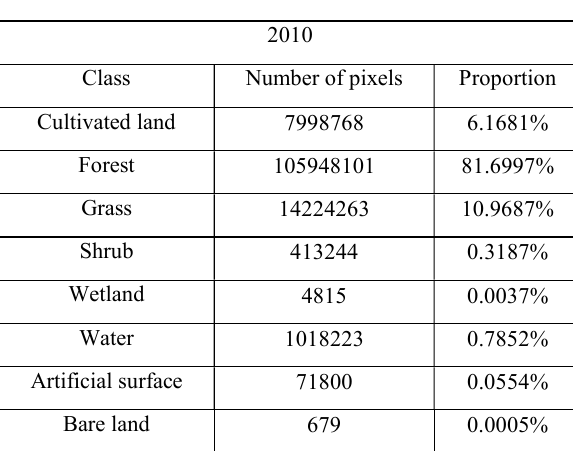
Table 5 Statistics of surface coverage types of products in 2000